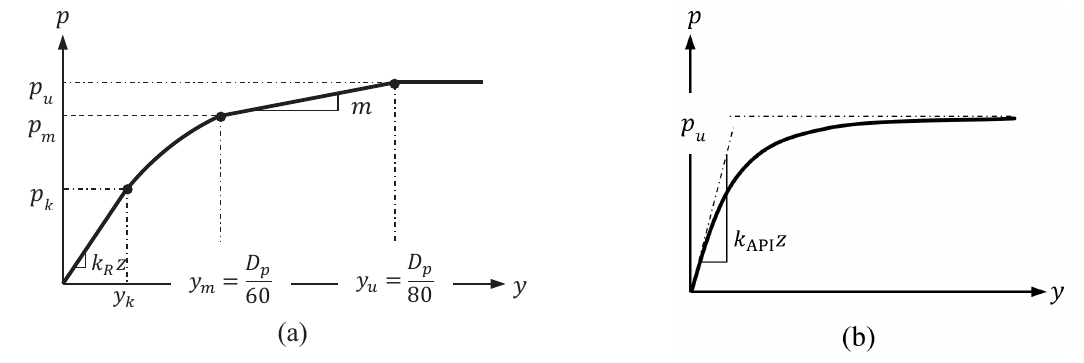
Figure 1: Original p–y curves. (a) Piecewise p–y curve proposed by Reese et al., (b) Hyperbolic formula suggested by the API.